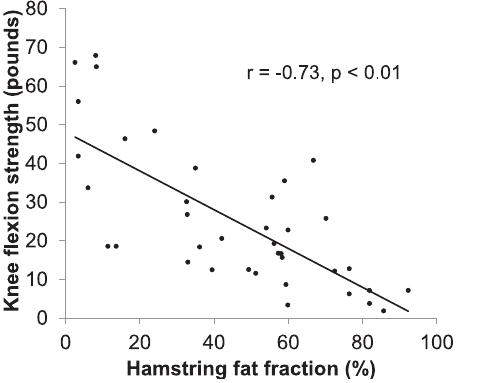
Figure 8. Strong correlation between 6 minute walk distance (6MWD) and hamstring average fat fraction, r= 2 .79 (p ,